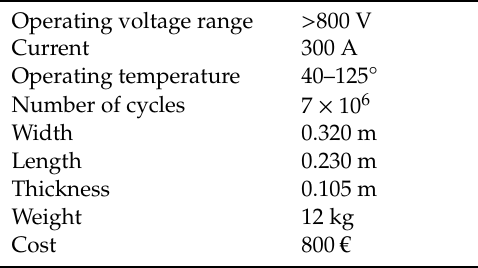
Table 12. Inverter